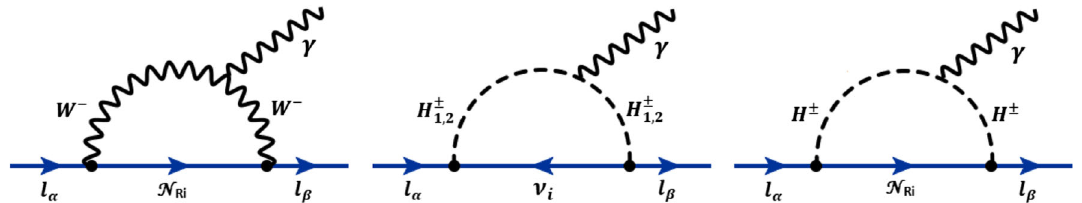
Fig. 5 Representative one-loop Feynman diagrams contributing to (cid:3) α → (cid:3) β + γ processes mediated by charged Bosons in minimal tree-level